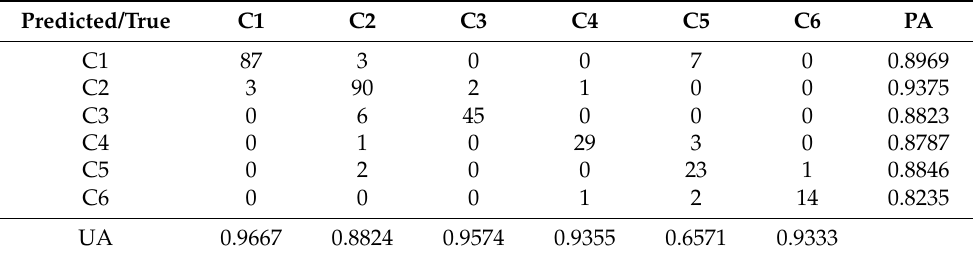
Table 5. Example of full confusion matrix (source: [37], Table 4 modified for our purposes—transposed, symbols of classes instead names).